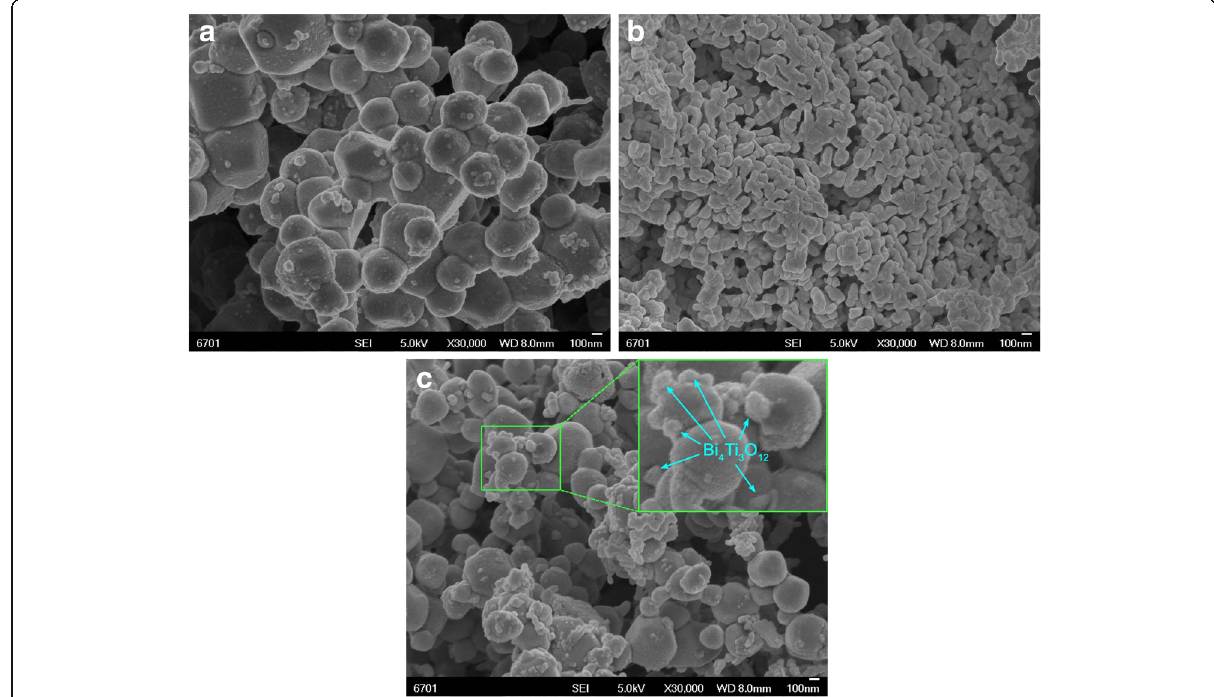
Fig. 2 SEM images of a Ag 3 PO 4 , b Bi 4 Ti 3 O 12 , and c 10%Bi 4 Ti 3 O 12 /Ag 3 PO